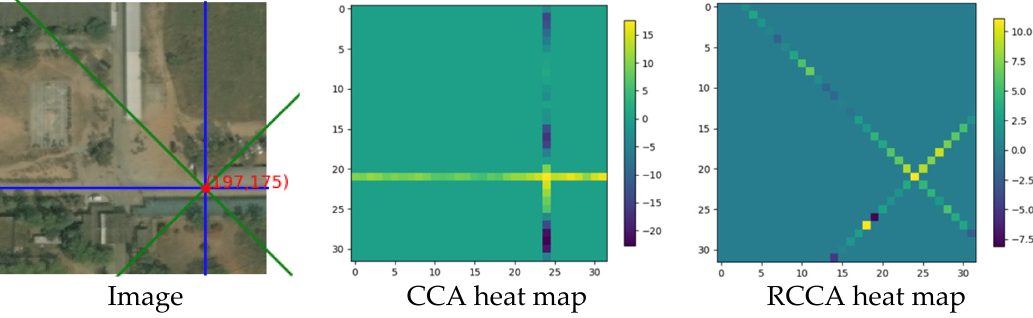
Figure 20. The heat map of energy distribution.